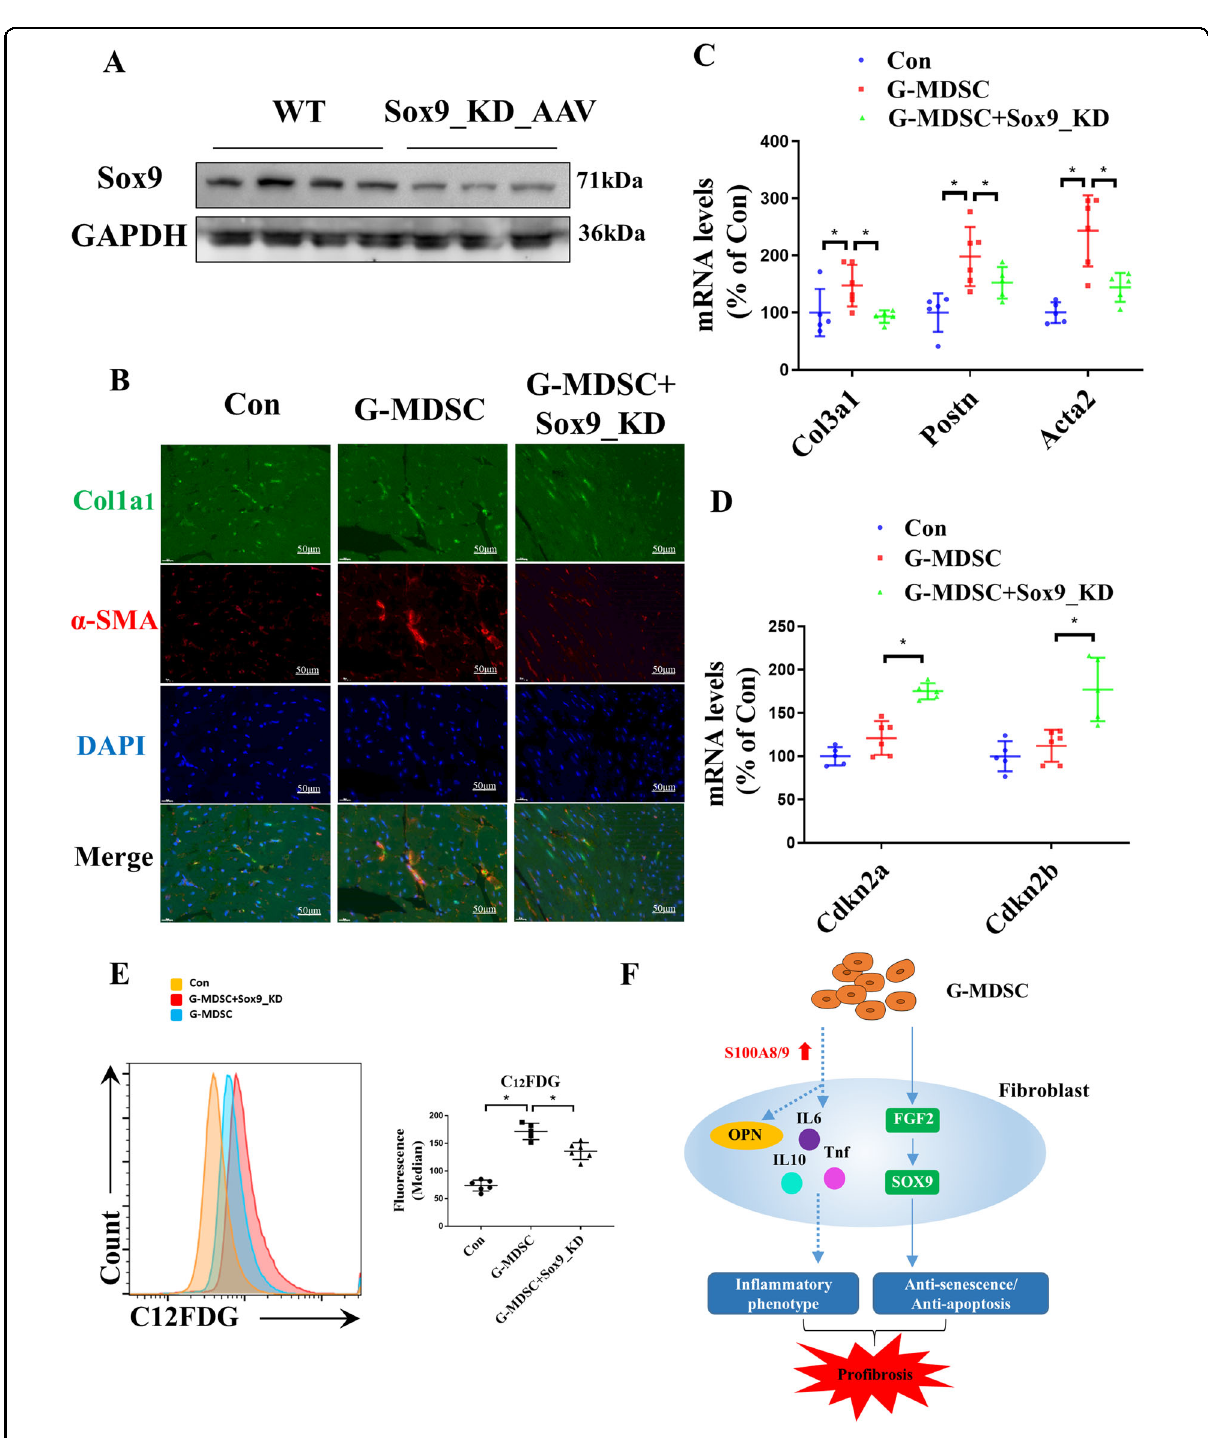
Fig. 7 SOX9 knockdown alleviates the fi brotic phenotypes induced by G-MDSCs in vivo. Induction of SOX9 knockdown in MDSC-treated mice through injection of AAV harboring the SOX9-KD plasmid. A Western blotting analysis showing the expression levels of SOX9 in the WT and SOX9_KD hearts. B Representative immuno fl uorescence images of the level of α -SMA in the control, G-MDSC, and SOX9_KD hearts. Scale bars, 50 μ m. C The mRNA levels of fi brosis markers (Col3a1, Postn, and Acta2) in mouse hearts analyzed by qPCR; n = 5 – 6 per group. D The mRNA levels of the senescence markers Cdkn2a and Cdkn2b in mouse hearts analyzed by qPCR; n = 5 – 6 per group. E The levels of β -galactosidase in fi broblasts analyzed by fl ow cytometry through C12FDG staining. Representative cytograms are shown on the left, and statistical data are shown on the right; n = 5 – 6 per group. F Diagram of the mechanism by which G-MDSCs act on fi broblasts. The data are presented as the means ± SDs. Differences were determined by an unpaired t -test or two-way ANOVA (more than 2 factors), and a Sidak HSD post hoc test was performed. * P <